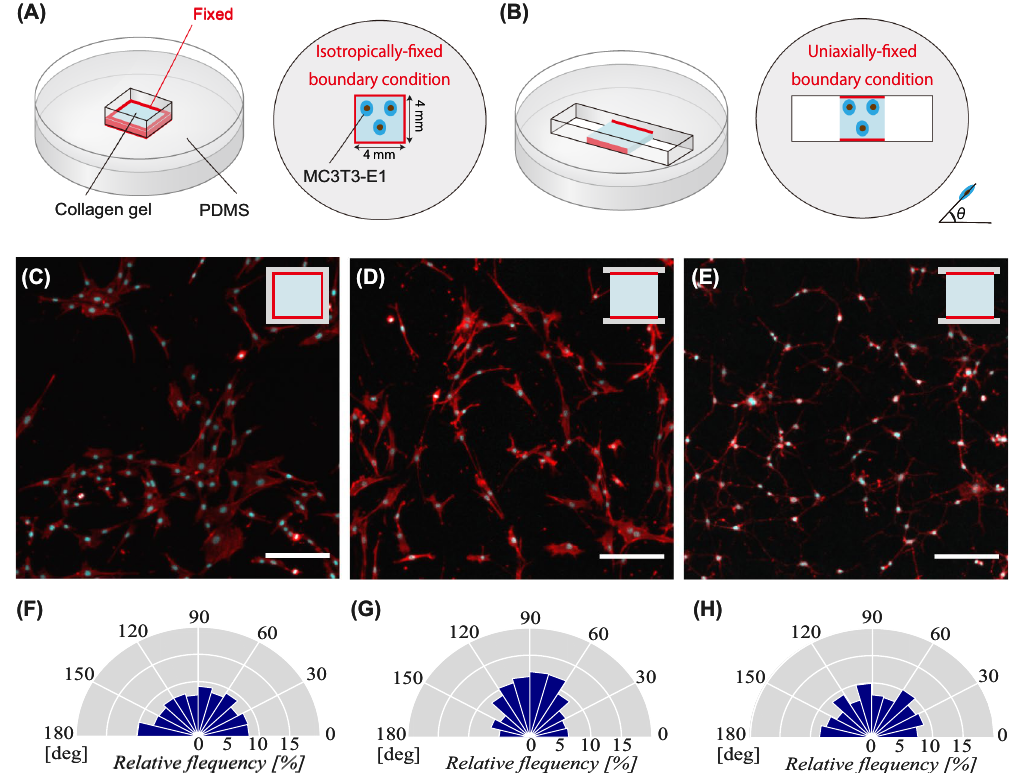
Figure 1. Schematic illustration of 3D collagen in vitro systems, ( A ) all-side fixed matrix and ( B ) 2-side fixed matrix, used to exert the isotropically- and uniaxially-fixed mechanical boundary condition, respectively. Images of DAPI and ACTIN staining of osteoblast-like cells cultured on ( C ) all-side fixed matrix and ( D ) 2-side fixed matrix for 1 day. ( E ) Images of DAPI and ACTIN staining of cells cultured on the 2-side fixed matrix for 1 day in the presence of blebbistatin. The ratios of cellular alignment of ( C ), ( D ), and ( E ) are depicted in ( F ), ( G ), and ( H ), respectively. Scale bars = 100